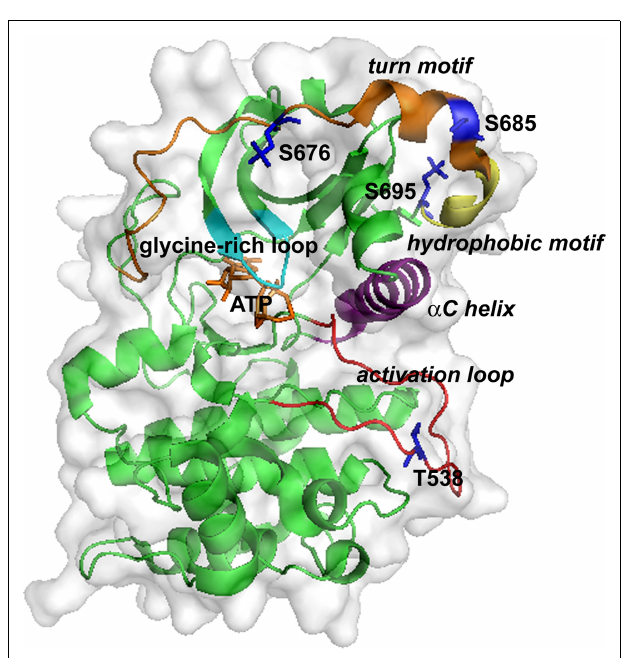
FIGURE 2 |Three-dimensional structure of the kinase domain of PKC- θ . ATP binds at a cleft between the N-lobe (top) and C-lobe (bottom). Key structural elements are highlighted: the glycine-rich loop (cyan), the α C helix (purple), the activation loop (red), the turn motif (orange), and the hydrophobic motif (yellow). Phosphorylation sites and ATP are shown as sticks in blue and yellow-orange, respectively.